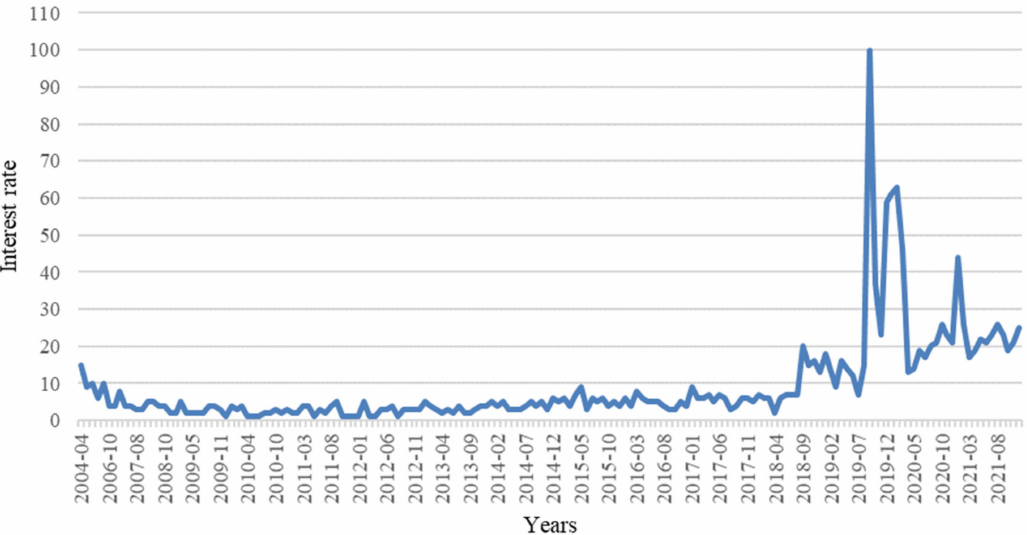
Figure 1. Fall detection interest rate, start April 2004-to-December 2021. The experimental data is taken from “Google Trends” based on “fall detection” as the search object. The results are equalized using the largest rates; therefore, the highest interest rate has a value of